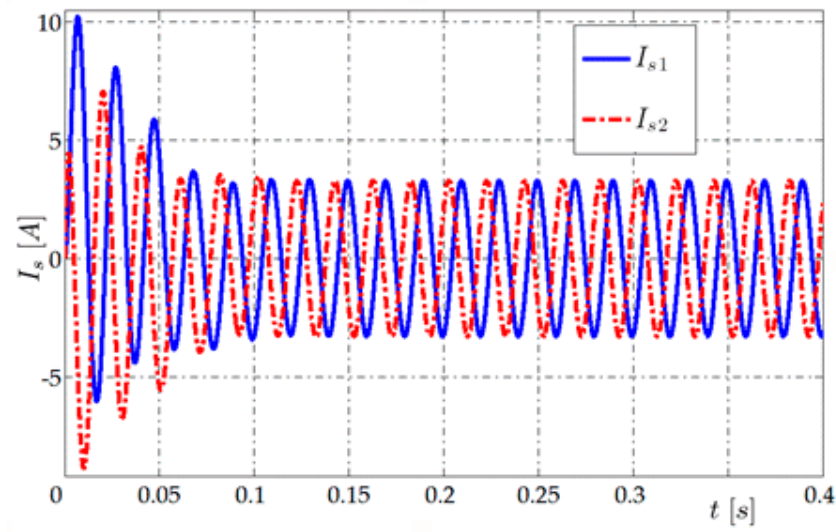
Figure 9. The phase currents in the stator windings during the start ‐ up motor for load torque 1 Nm.